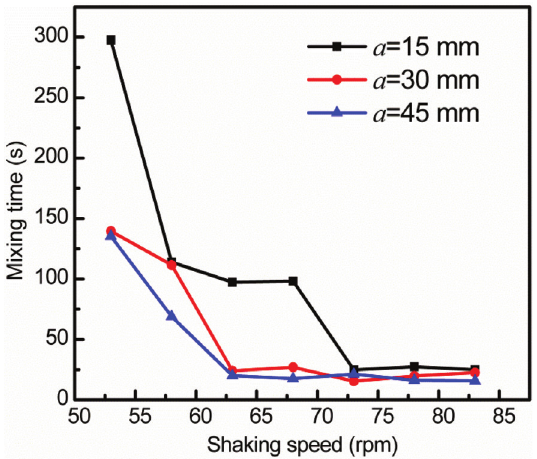
Fig. 10: Measured mixing time as a function of shaking speed with different eccentricities at H = 84